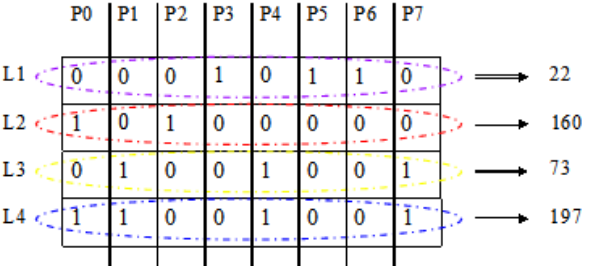
Figure 5. The finally new feature. Each column (P0~P7) represents the sub-feature at different orientations of the center point. Each row (L1~L4) represents the final BG2D2LRP feature of the center